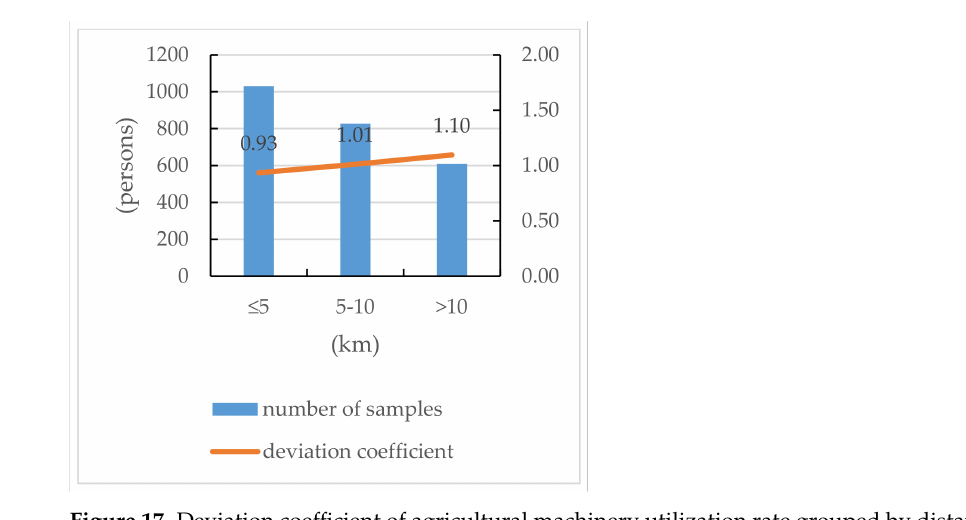
Figure 17. Deviation coefficient of agricultural machinery utilization rate grouped by distance from residence to town.